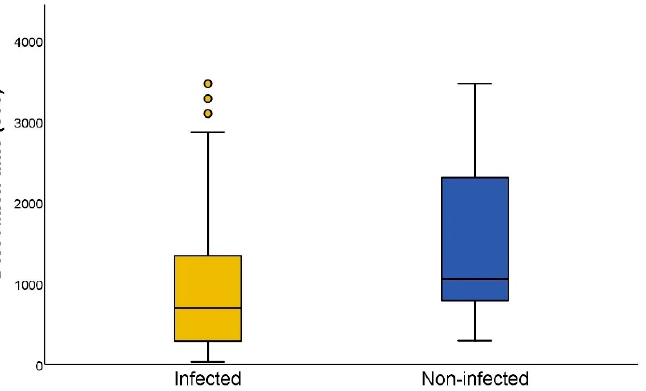
Figure 4. Defecation time, in seconds, of Trypanosoma cruzi -infected and non-infected Triatoma infestans . Defecation time is defined as the time elapsed between the end of the blood intake and the start of the dejection release. The circles represent outliers, calculated as previously reported [24].